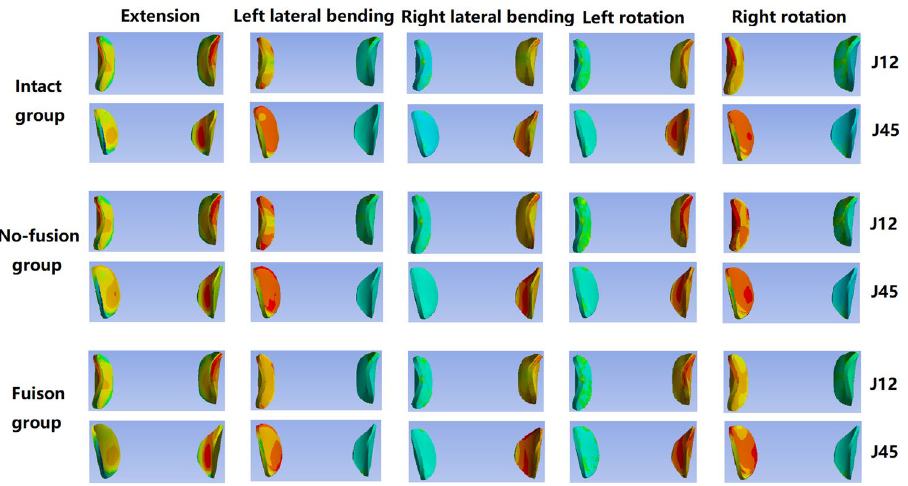
Figure 4. The von Mises stress distributions of the adjacent facet